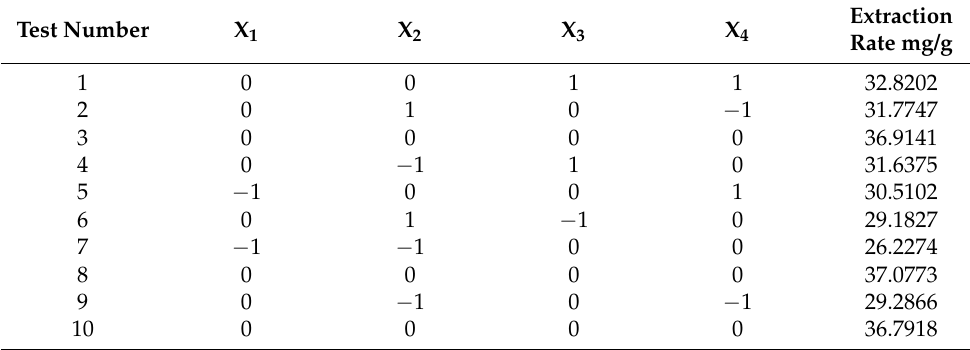
Table 1. Response surface optimisation test